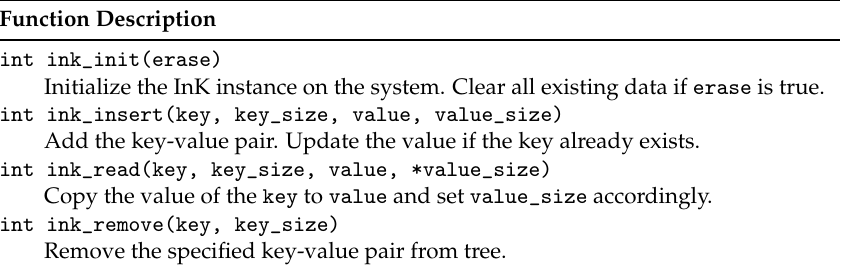
Table 1. InK system calls for key-value operations.